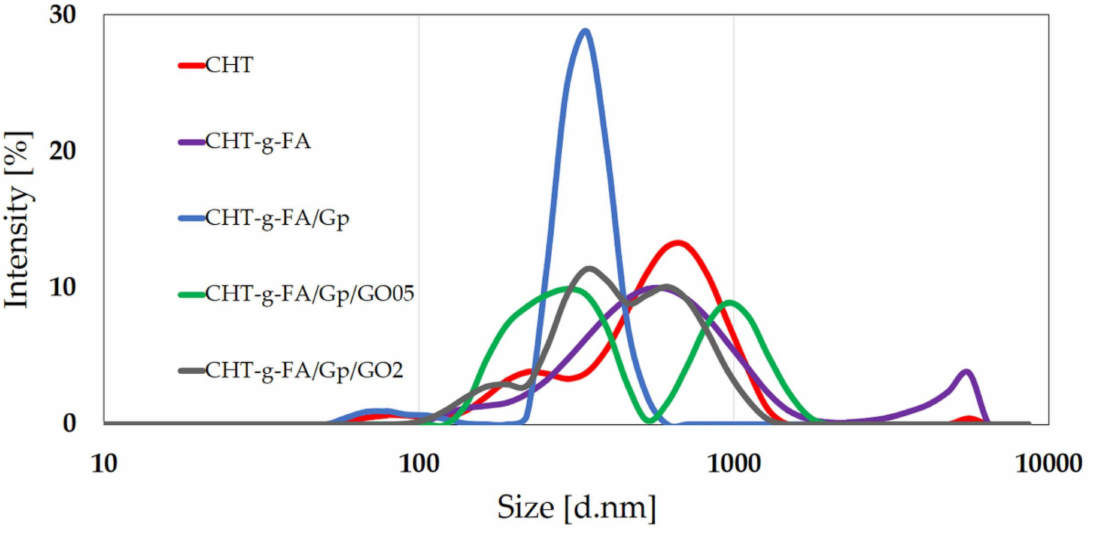
Figure 2. Size distribution chart of CHT and modified CHT constructs from the DLS